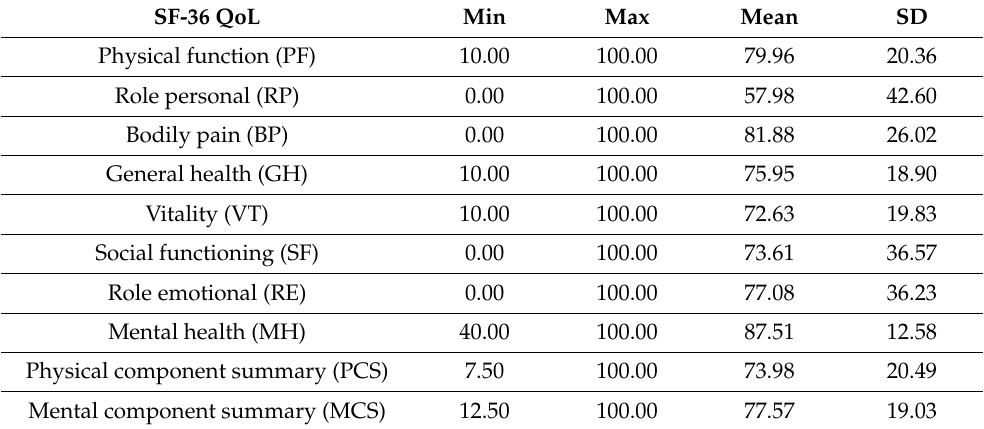
Table 4. Descriptive statistics for SF-36.